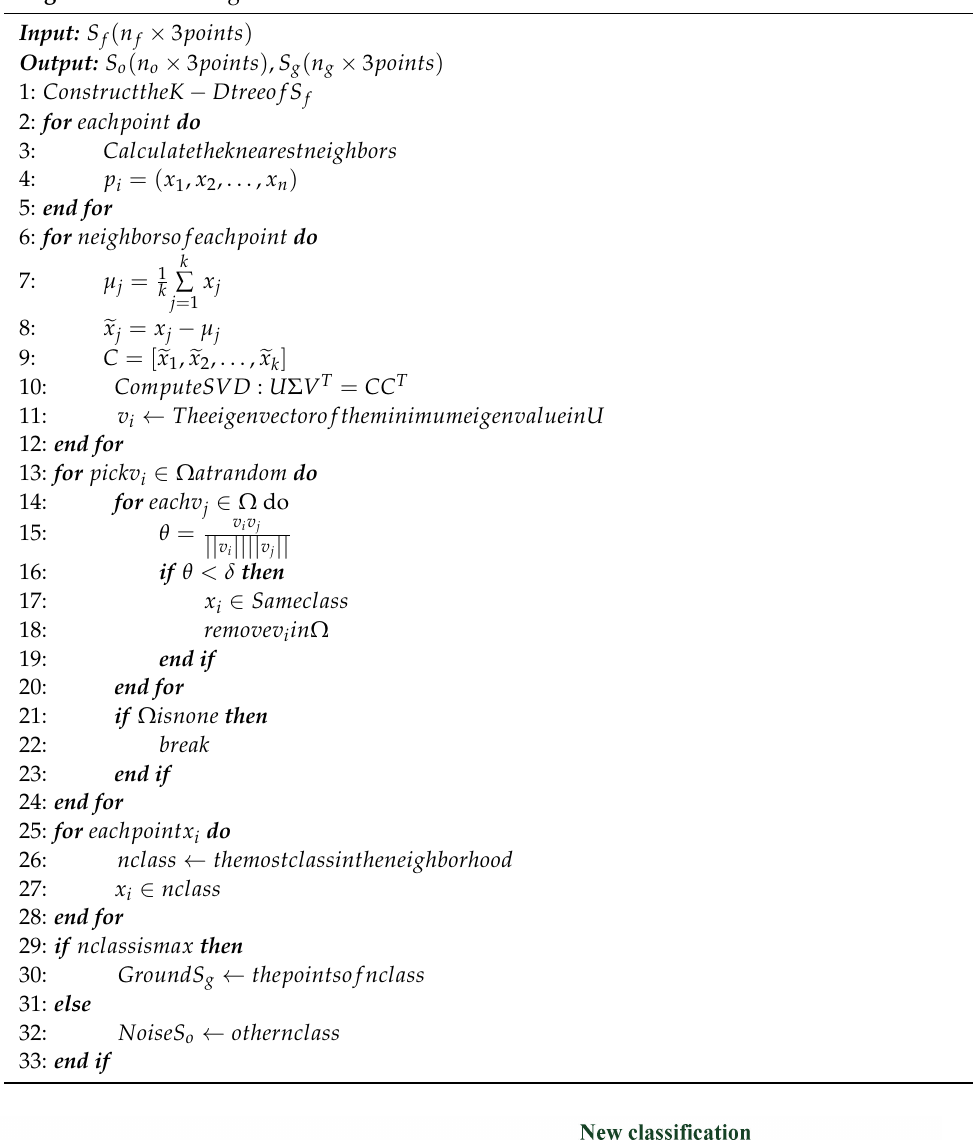
Algorithm 2. Filtering based on NKNN